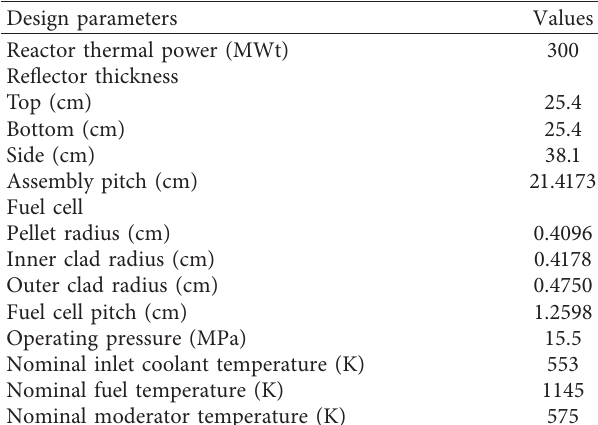
Table 1: Main design